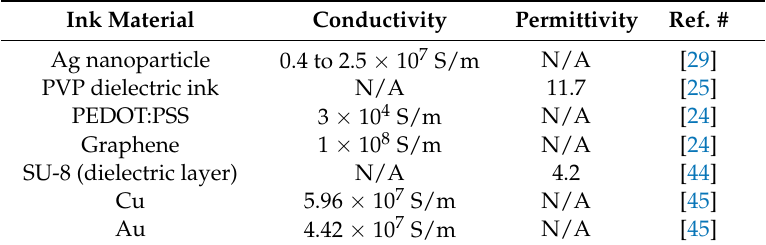
Table 4. Conductivity and permittivity of most used metallic nanoparticle inks and dielectric inks, respectively.